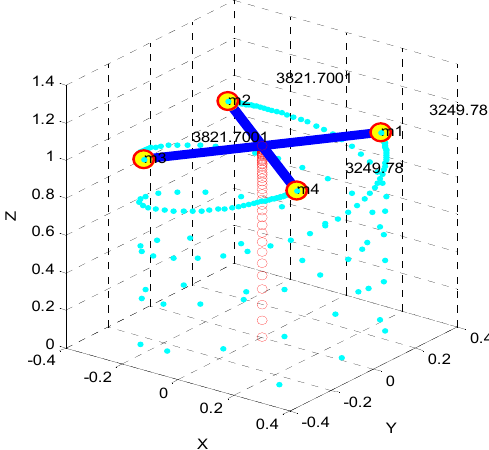
Figure 19. The quadcopter’s operation along a spiral path.